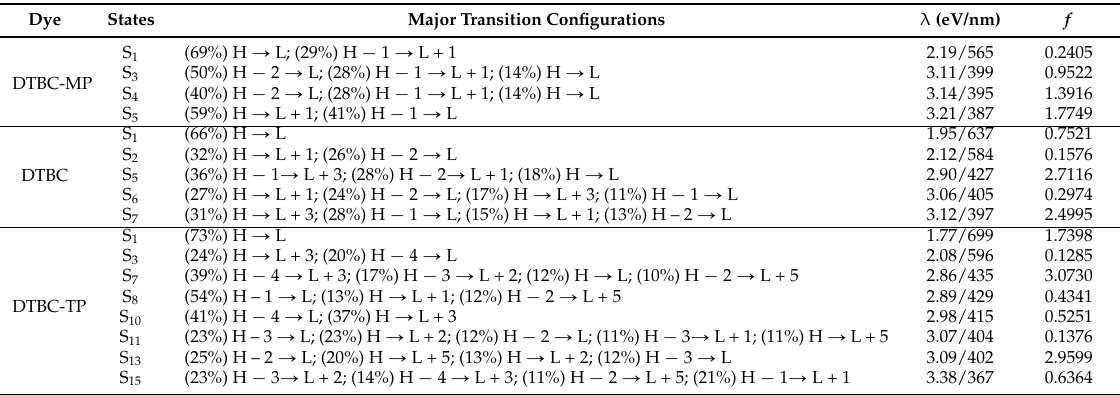
Table 2. The calculated excitation energies (eV), excitation wavelength (nm), oscillator strengths ( f ) and major transition configurations with coefficients larger than 10% of DTBC-MP, DTBC,